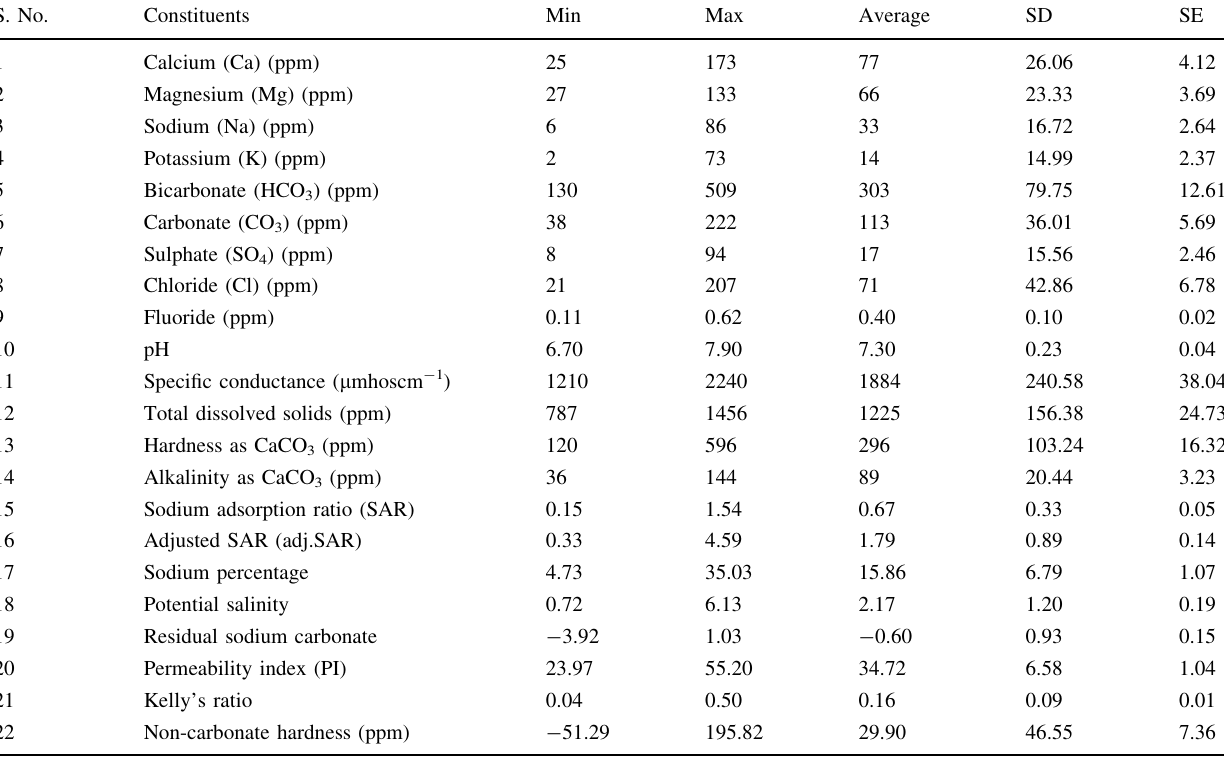
Table 1 Descriptive statistics for groundwater samples of Tummalapalle area S.